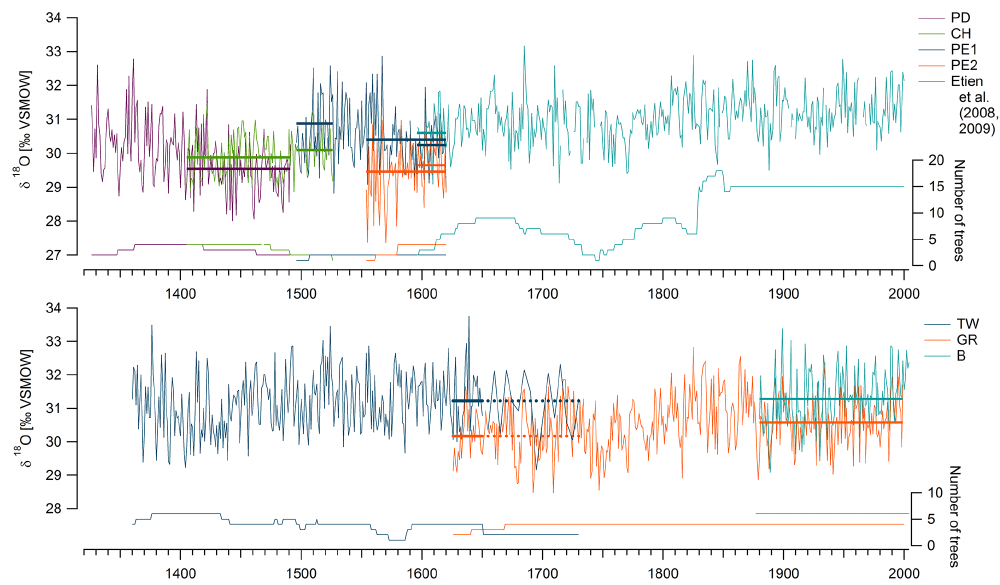
Figure 4. Cohort offsets. Top: The δ 18 O c series for different tree cohorts from Fontainebleau. Bottom: the δ 18 O c series for living tree cohorts (B and GR), and timber wood (TW) from Angoulême. Horizontal lines indicate the mean of each series for the period of overlap. TW samples have been measured every 5th year only in the period covered by the dotted